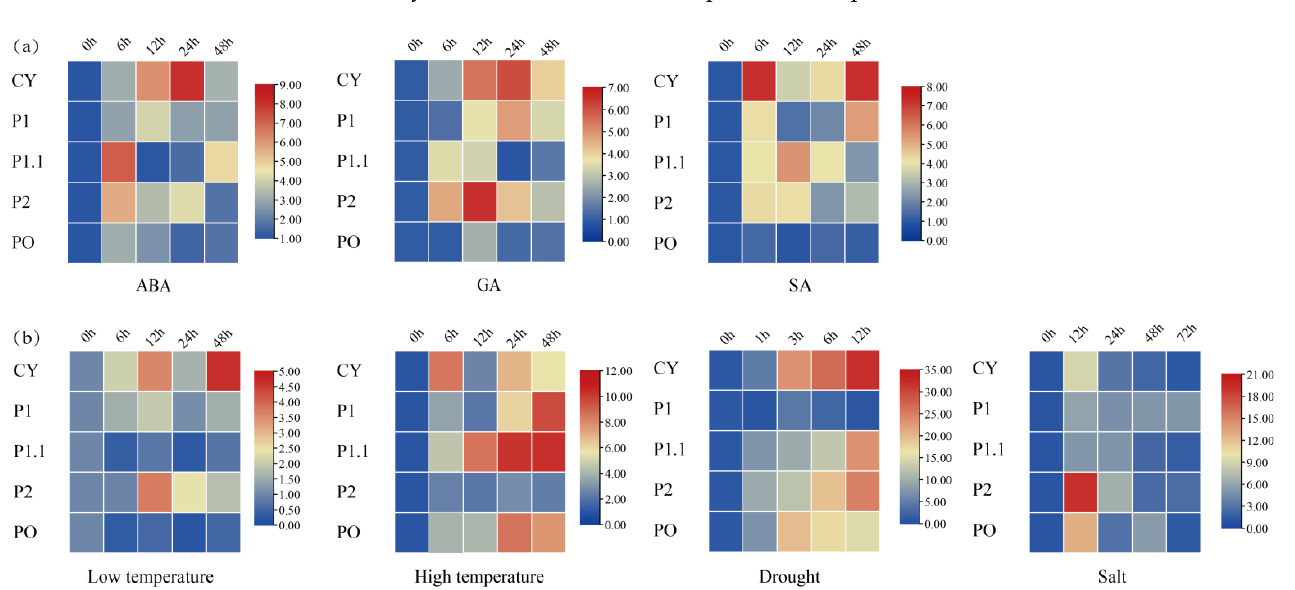
Figure 7. Expression pattern of FaG6PDH in fruit of strawberry under ( a ) hormones treatments and ( b ) stress treatments for 0 h to 72 h.